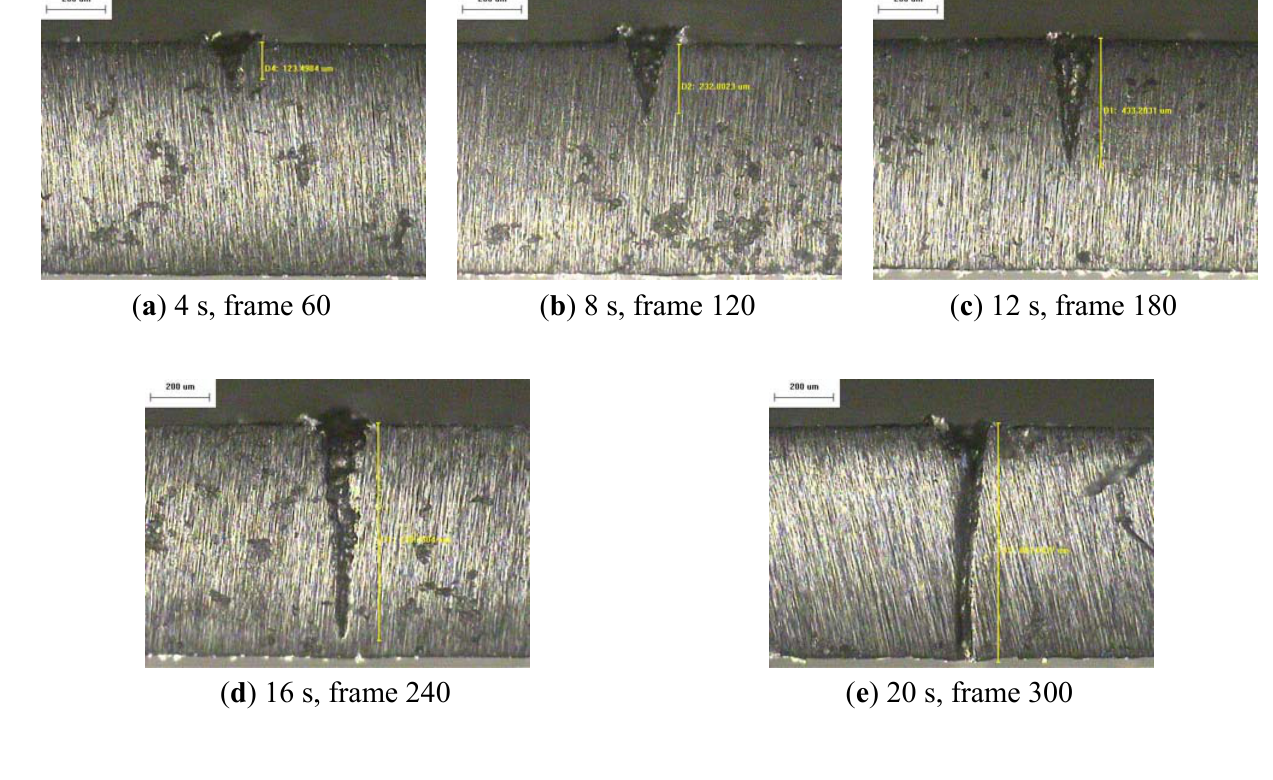
Figure 9. Workpiece (SS 420) profile images at different process times (radiation energy is 175 mJ): ( a – e )